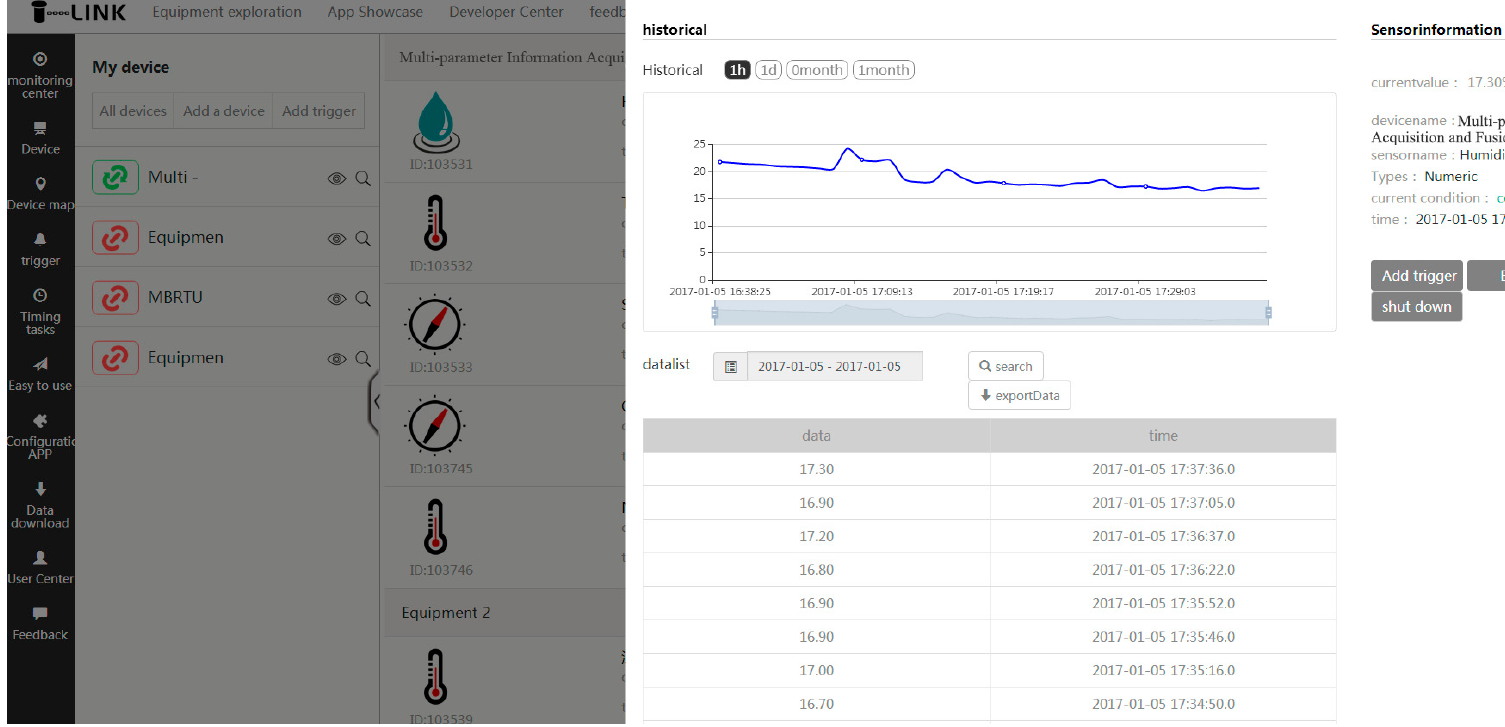
Figure 12. Historical graph of humidity.